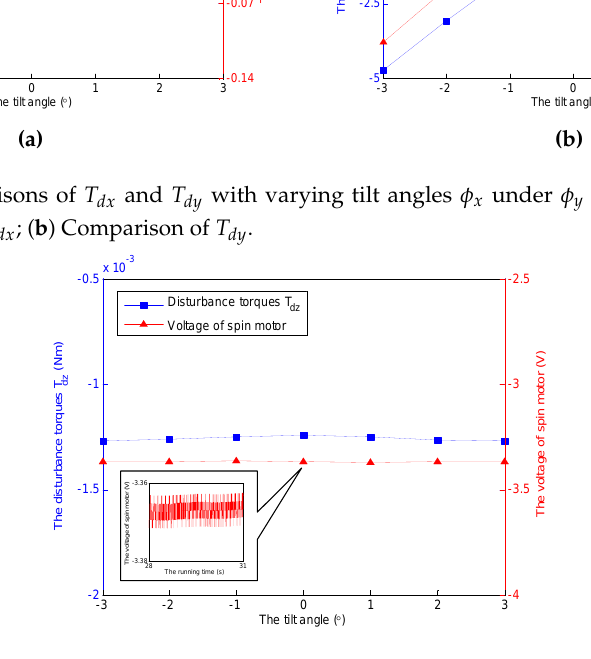
Figure 15. Comparison of T dz with varying tilt angles φ x under φ y = 0 ◦ and 3500